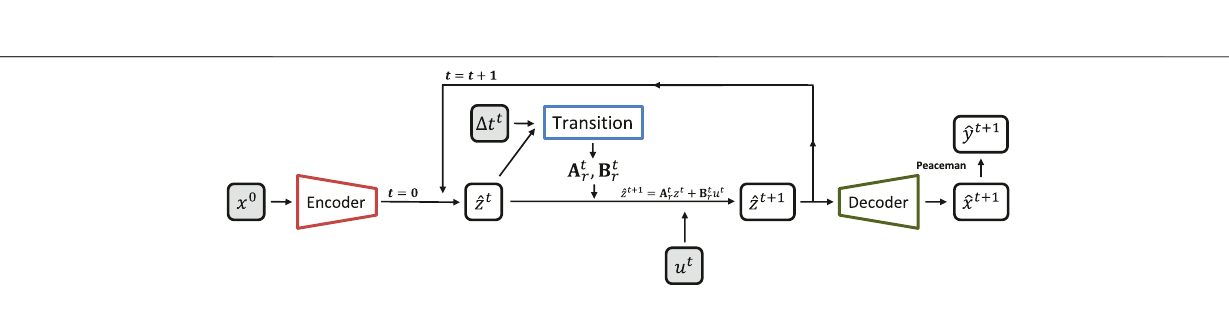
FIGURE 5 | Training diagram for E2CO with fl ux and well data loss functions (proposition 3).